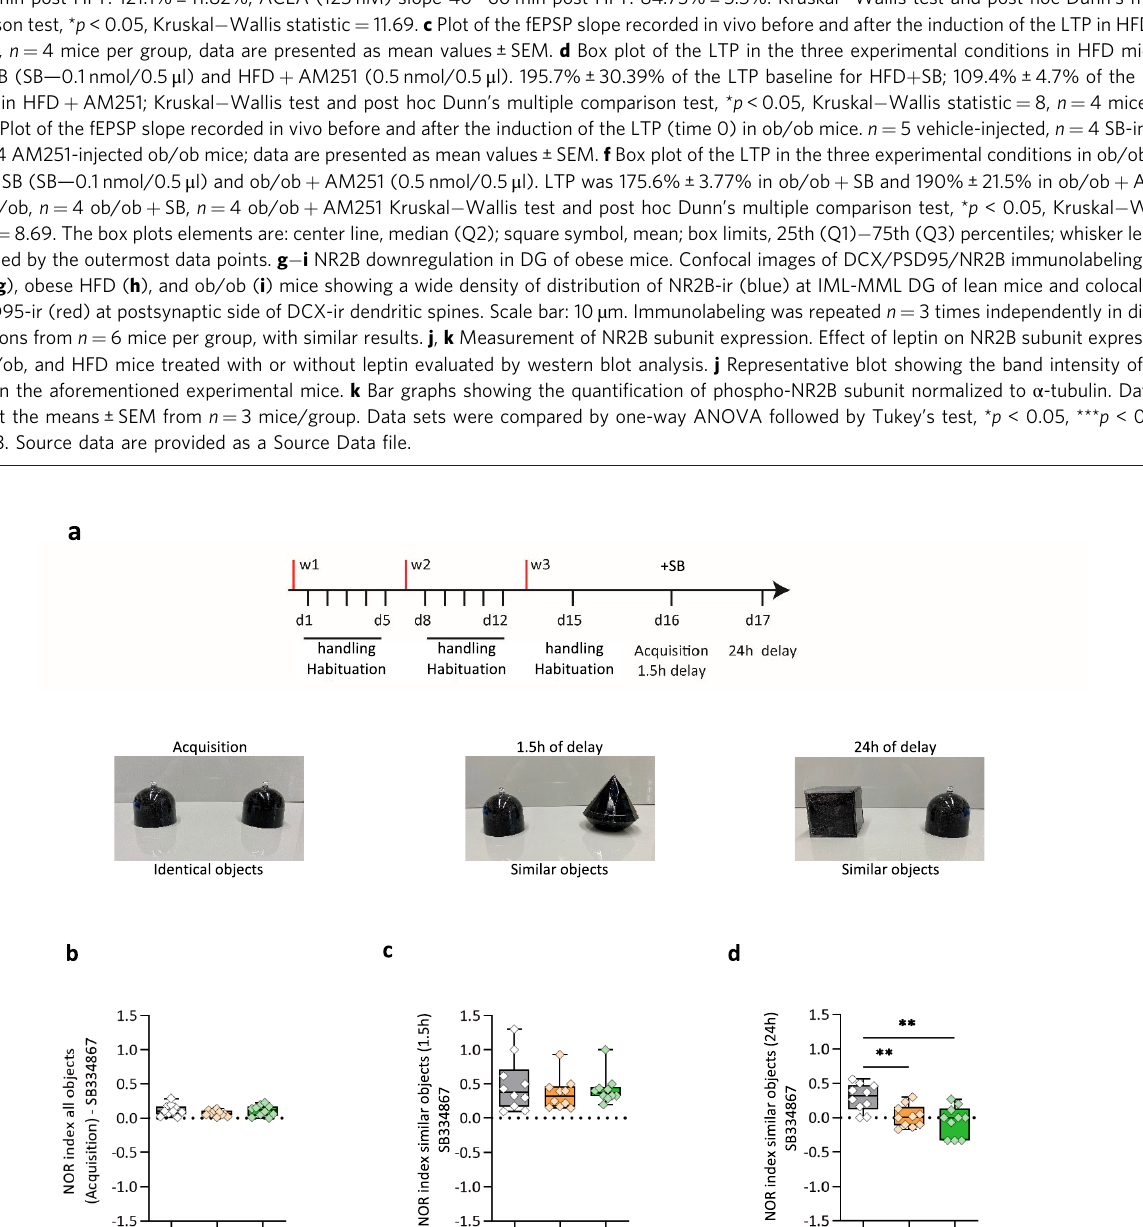
Fig. 8 The alterations in pattern separation in obese mice are partly rescued by blocking OxA/Ox1-R signaling. a Representative scheme and timeline of the novel object recognition test, animals were injected i.p. 1.5 h before with SB (30 mg/kg, i.p). b NOR in lean, HFD, and ob/ob mice calculated during habituation phase. c Short-term retention phase, NOR in lean, HFD, and ob/ob mice calculated after 1.5 h. d Long-term retention phase, NOR = 0.29 ± 0.06 in lean, NOR = 0.02 ± 0.05 in HFD, NOR = − 0.04 ± 0.06 in ob/ob mice calculated after 24 h. ** p < 0.01, ANOVA test and Bonferroni post hoc test, F = 8.6, n = 10 mice per group. The box plots elements are: center line, median (Q2); square symbol, mean; box limits, 25th (Q1) − 75th (Q3) percentiles; whisker length is determined by the outermost data points. Source data are provided as a Source Data fi